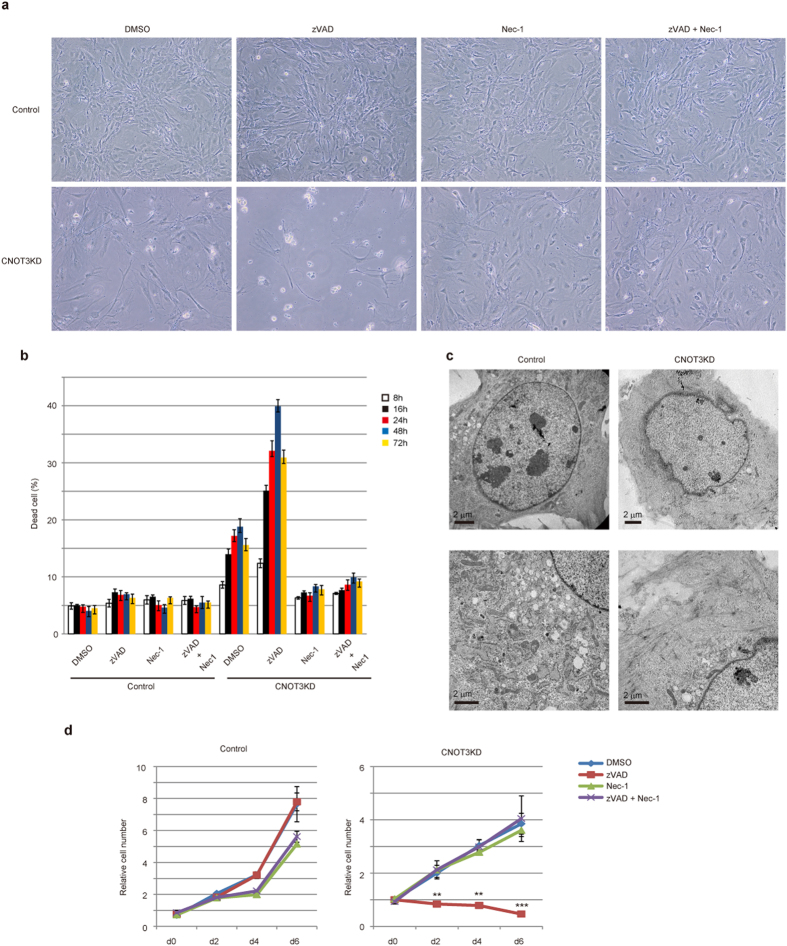
CNOT3-depleted MEFs undergo necroptosis.(a) Morphology of control and CNOT3-depleted MEFs (CNOT3KD) 2 days after treatment with dimethyl sulfoxide (DMSO), zVAD, Nec-1, or a combination thereof. Photographs are at the same magnification. (b) Cell death assessed by propidium iodide (PI) uptake using flow cytometry of treated MEFs at the indicated time points after an addition of the indicated chemicals. n = 3. (c) Transmission electron microscopy of control (left panels) and CNOT3KD MEFs (right panels). (d) Growth curves corresponding to control (left) and CNOT3KD MEFs (right) treated with indicated chemicals. Day 0 corresponds to 4 days after retrovirus infection. Each time point was determined in triplicate. All values represent means ± sem. **P < 0.01; ***P < 0.001